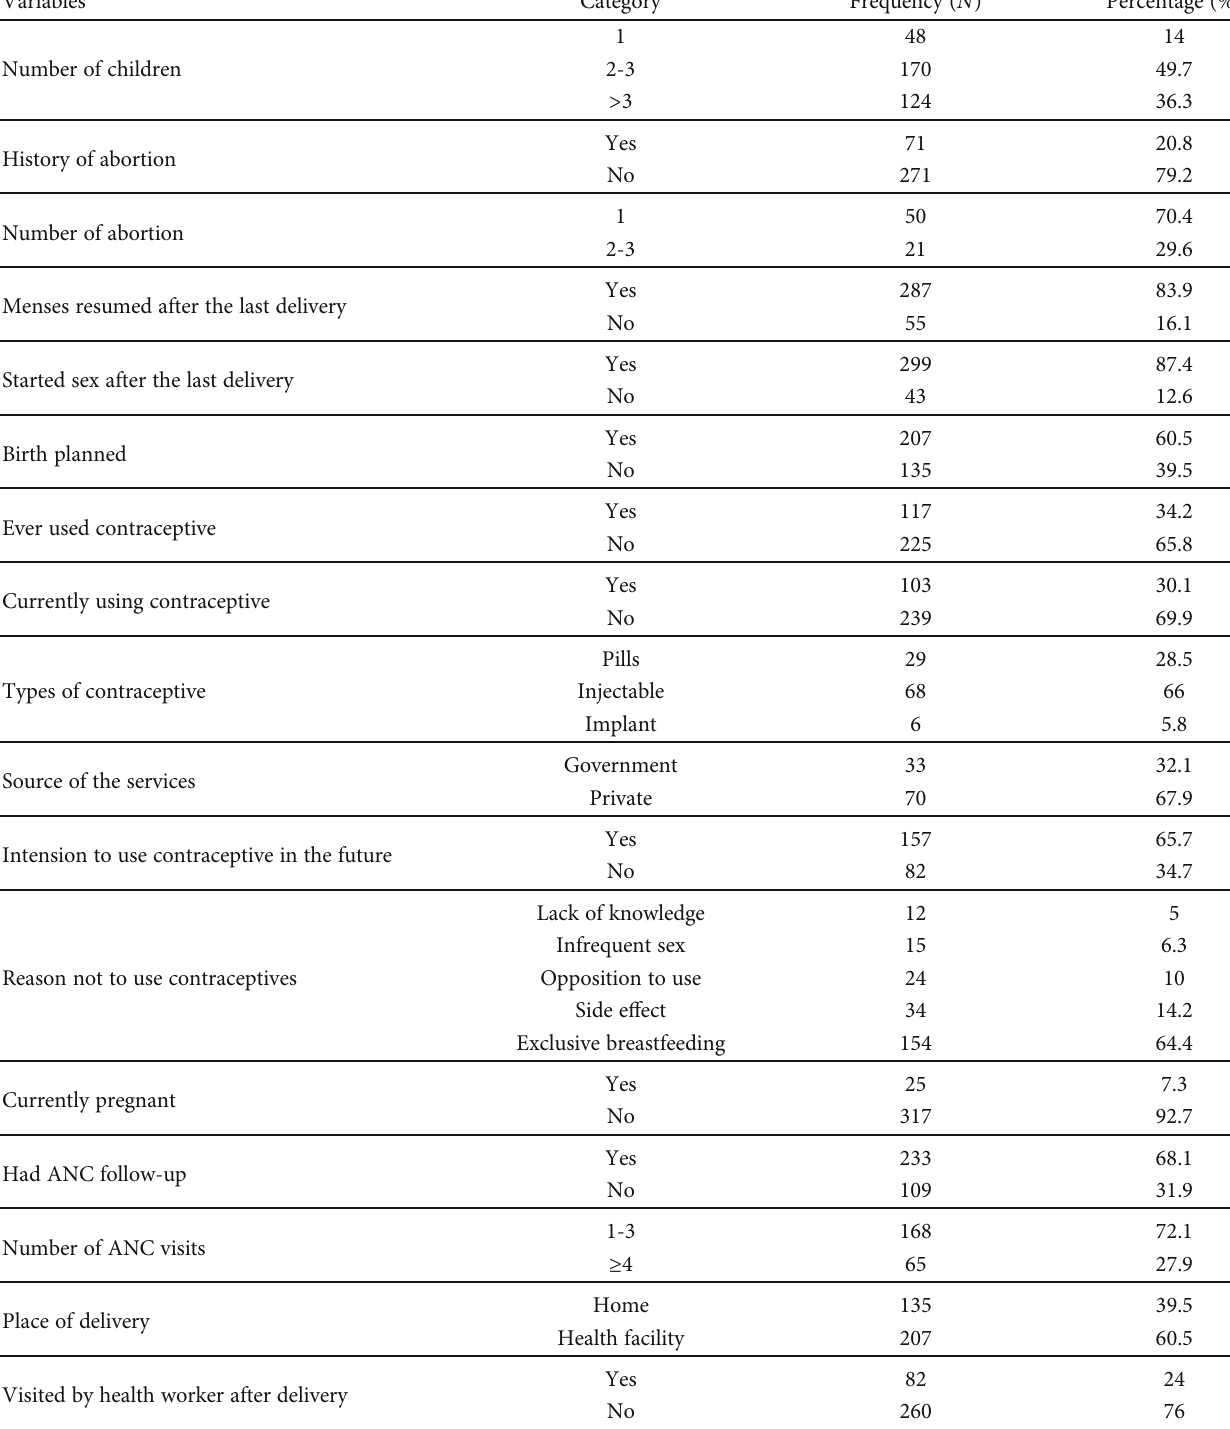
Table 2: Reproductive and health services characteristics of the study participants in Dubti town, pastoral community, Afar region, Northeast Ethiopia, May